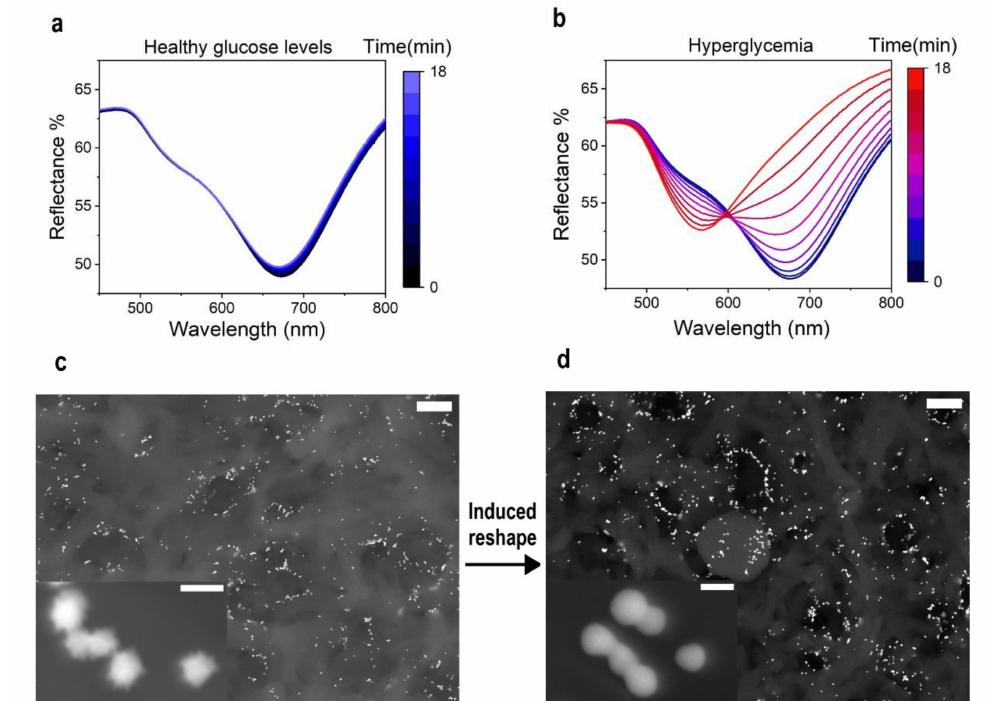
Figure 2. Detection mechanism characterization. Reflectance spectroscopy (diffuse mode) spectra of ( a ) a healthy glucose level saliva sample (1.5 mg/dL) and ( b ) a sample spiked with D-(+)-Glucose to simulate a hyperglycemic state (9.5 mg/dL), monitored for 18 min. The sample with healthy levels of glucose maintained its reflectance spectra stable over the time, while the hyperglycemic sample reflectance peak shifted from 670 to 560 nm. Bottom: HR-SEM micrographs of polyamide membranes casted with homogenously dispersed MGNPs before the test ( c ) and reshaped GNP spheres after the test ( d ) (scale bars: low magnification 1 µ m; high magnification 50